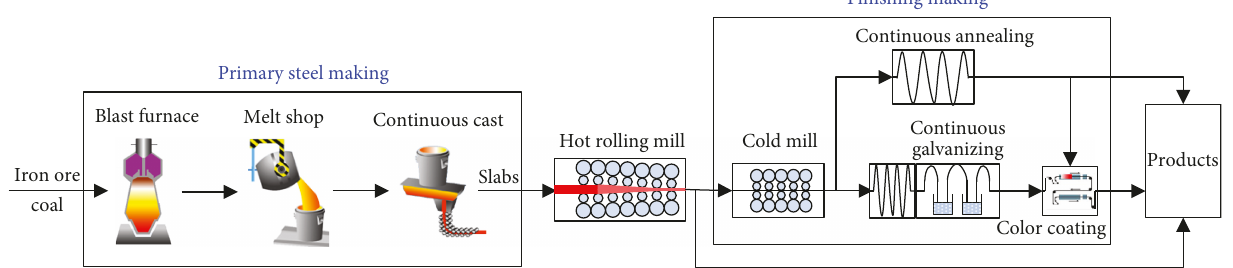
Figure 1: Production process in a hot rolling mill.